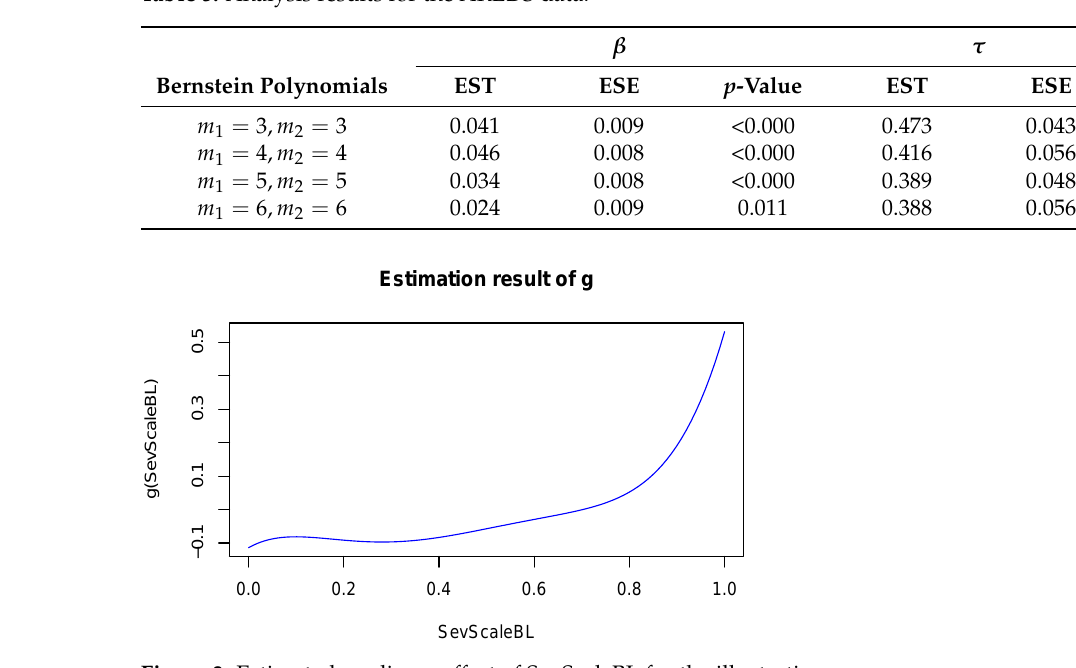
Table 5. Analysis results for the AREDS data.